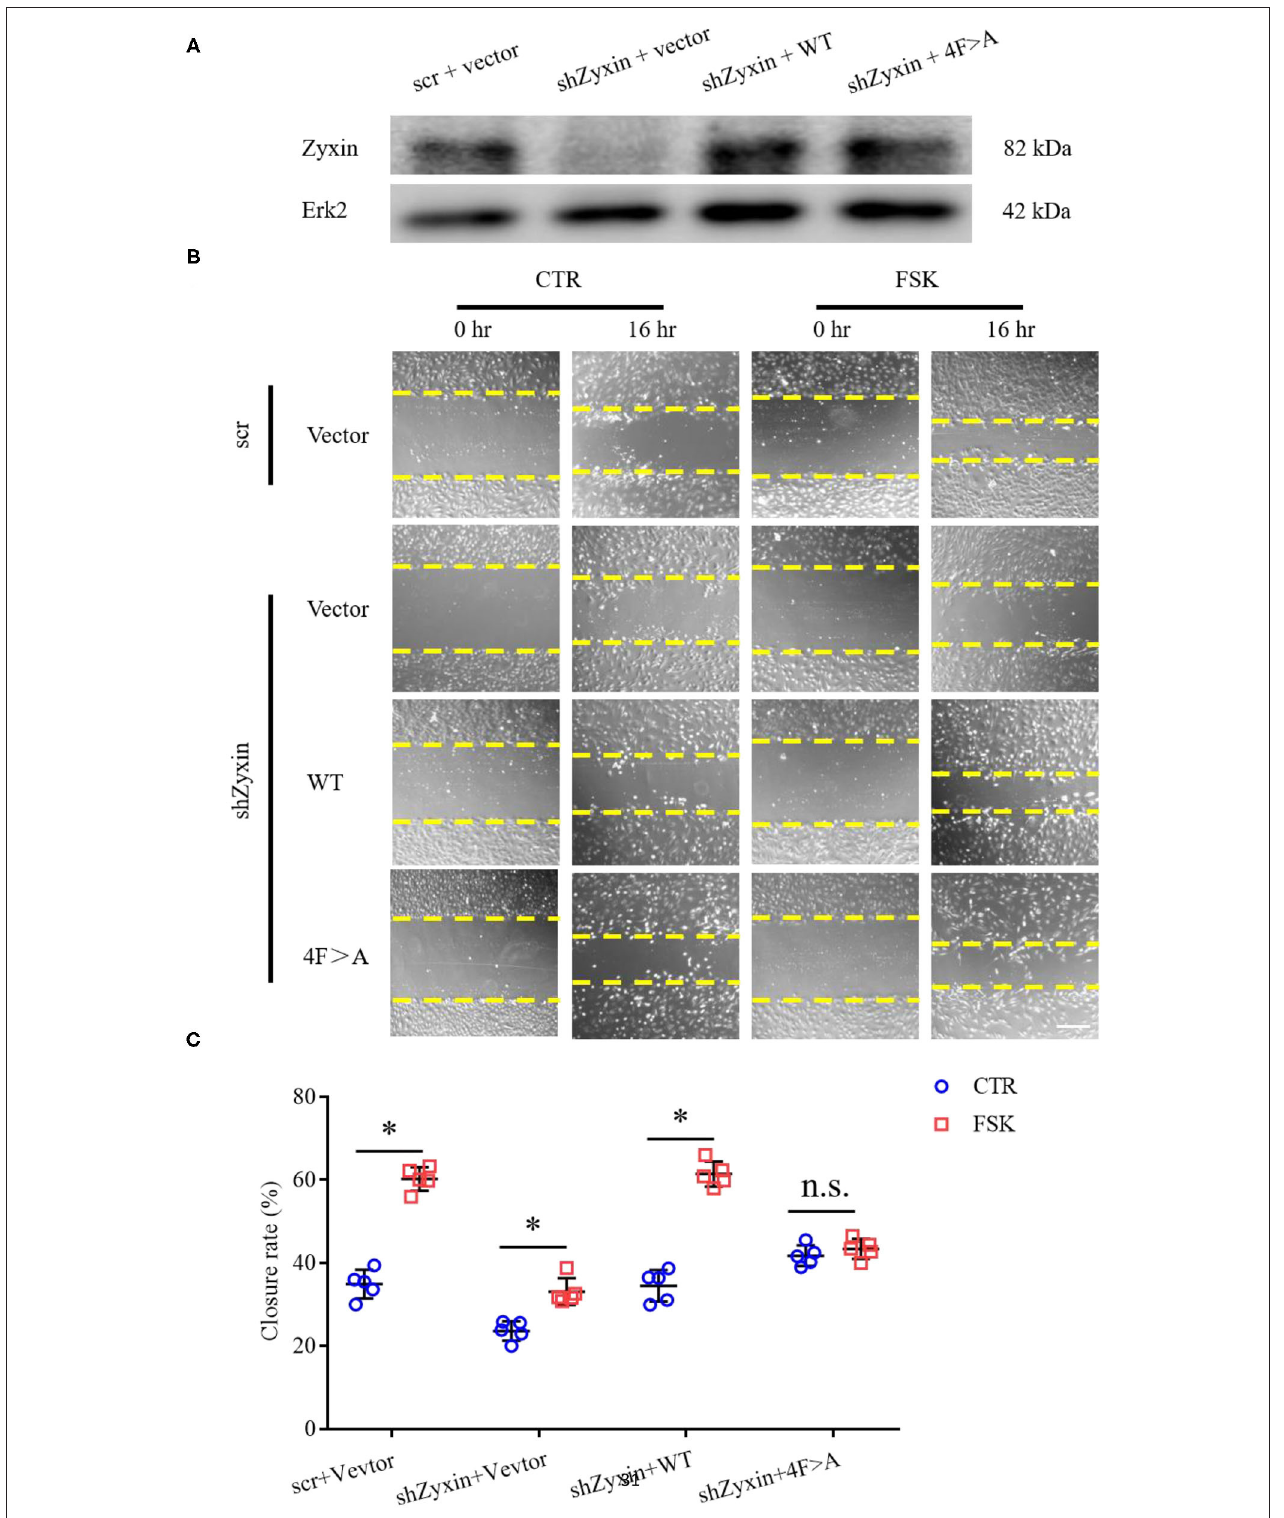
FIGURE 7 | Decreased migration under cAMP pathway stimulation is vasodilator-stimulated phosphoprotein (VASP)-independent in zyxin deleted HUVECs. (A) Western blots of protein levels of both zyxin and the zyxin 4F > A mutant, and Erk2 in HUVECs. (B) Representative images of the effect of zyxin on HUVEC migration under cAMP pathway stimulation in the presence of forskolin (FSK: 5 µ M) or vehicle (CTR) assessed by scratching wound-healing assay 0h and 16h post scratching (scale bar, 500 µ m). (C) Quantification of mean closure rate 16h after scratching. Mean ± SD, n = 5, * P < 0.05, n.s., not significantly different. Test of normality: P > 0.05, test of homogeneity: P >